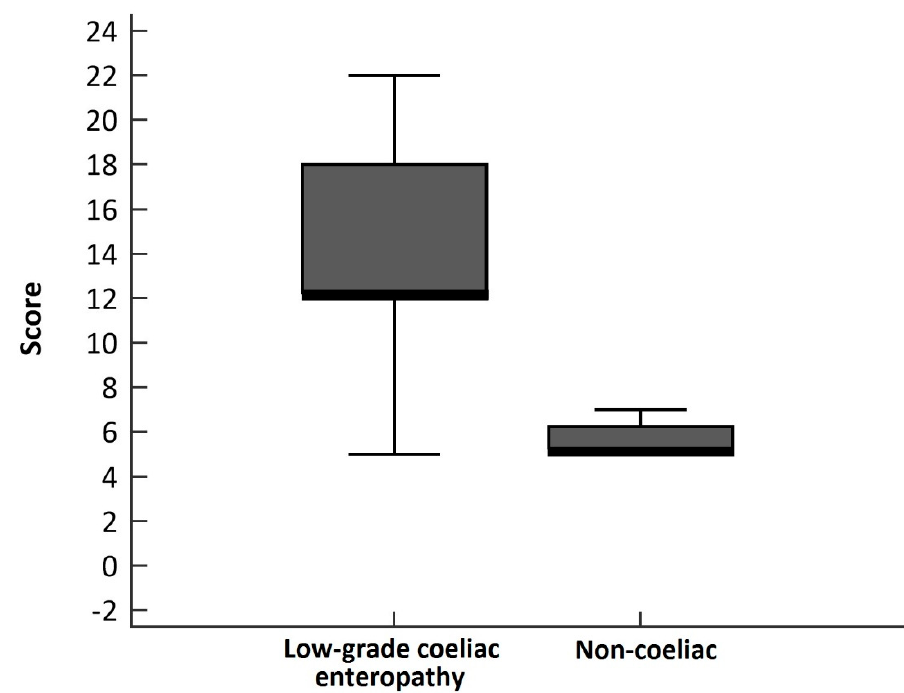
Figure 2. Boxplot chart showing the distribution of the derived score by final diagnosis.